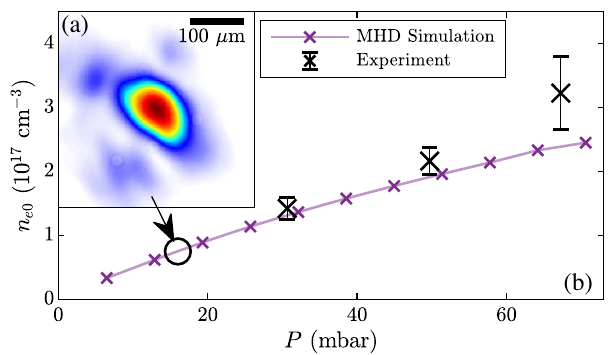
FIG. 4. (a) Measured transverse fluence profile of the guided beam at the exit of a 50 mm long HOFI plasma channel formed at τ ¼ 3 . 0 ns and P ¼ ð 17 (cid:2) 1 Þ mbar. (b) Comparison of the on- axis electron density measured by interferometry (symbols) and that calculated by MHD simulations (solid line) for τ ¼ 3 . 0 ns and P ¼ 17 mbar. The axial electron density calculated by the MHD simulations for P ¼ 17 mbar is 7 × 10 16 cm − 3 .